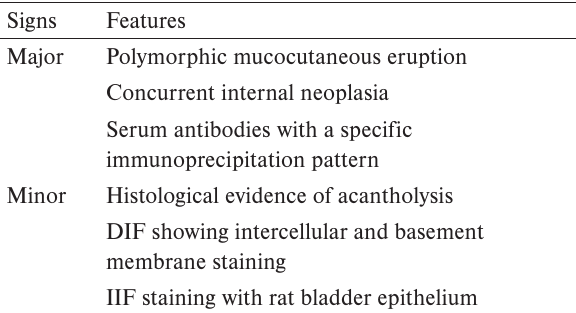
Table 1. Paraneoplastic pemphigus diagnostic criteria modi- fied by Camisa and Helm 2